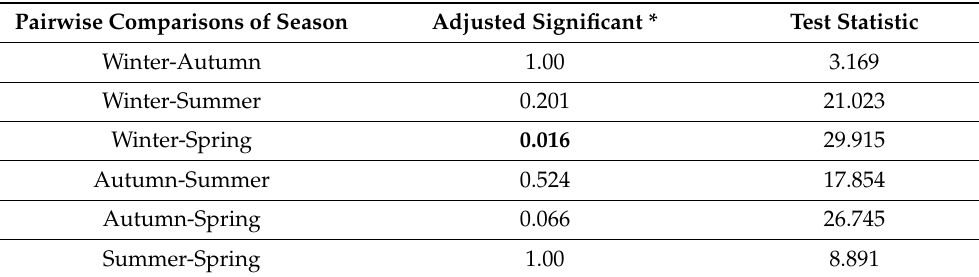
Table 6. The result of the pairwise comparison test by NH 3 concentration at NPK fertilizer production